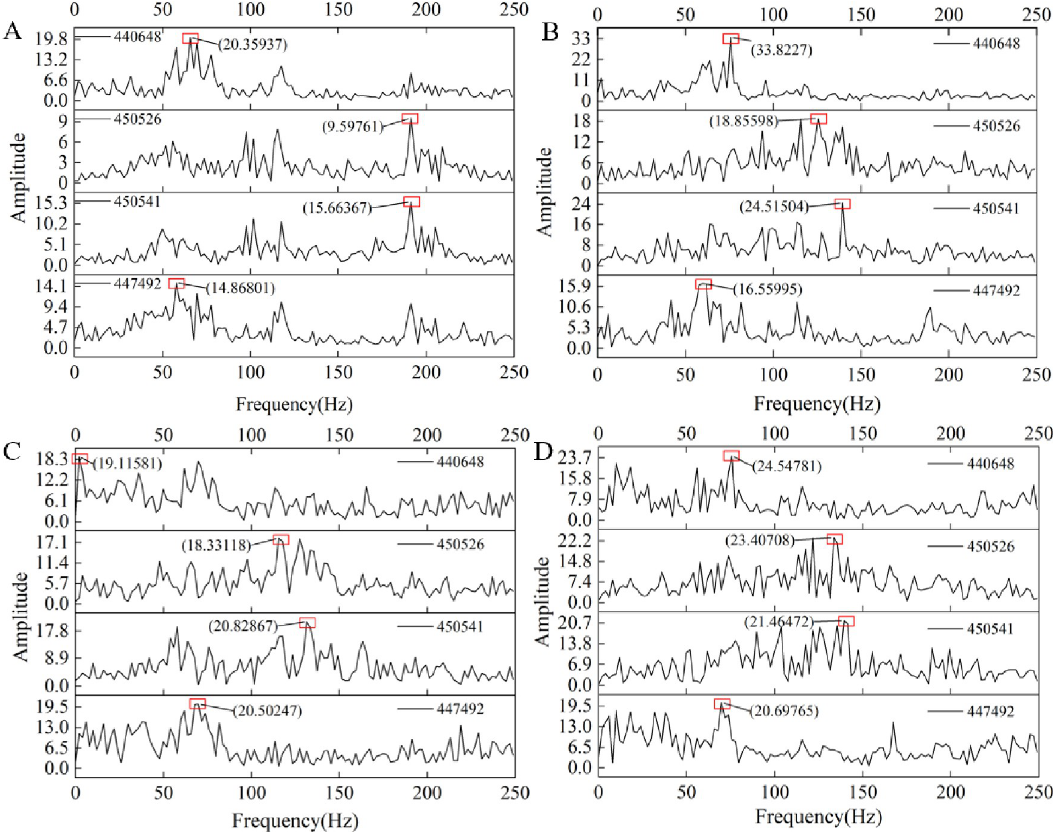
Fig 16. The amplitude spectrum of four nodes with different gangue content. (A) The gangue content of 0%. (B) The gangue content of 25%. (C) The gangue content of 50%. (D) The gangue content of 75%.